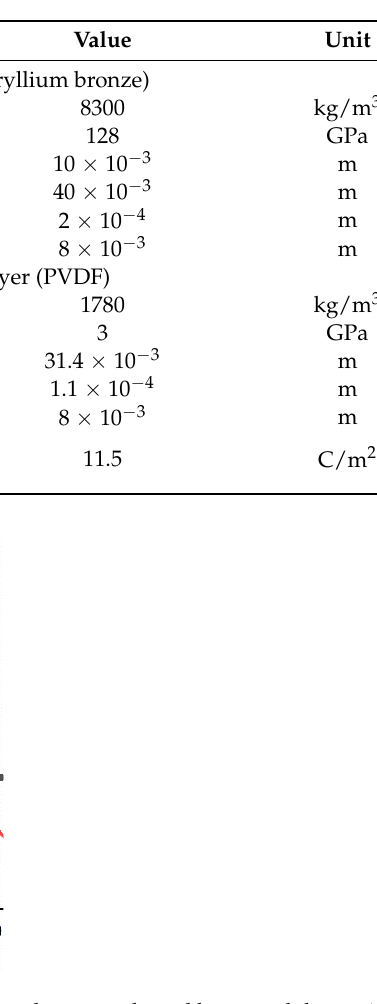
Table 1. Material parameters for simulation.